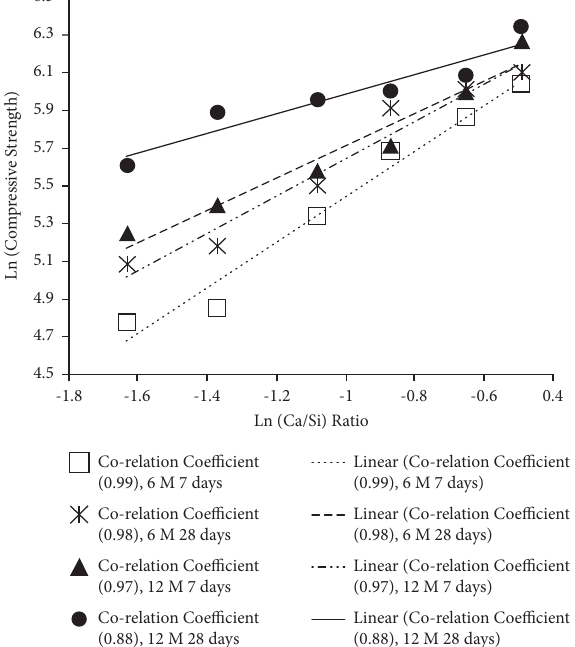
Figure 6: Correlation coefficient between experimental compressive strength and Ln, Ca/Si ratio for 6M and 12M